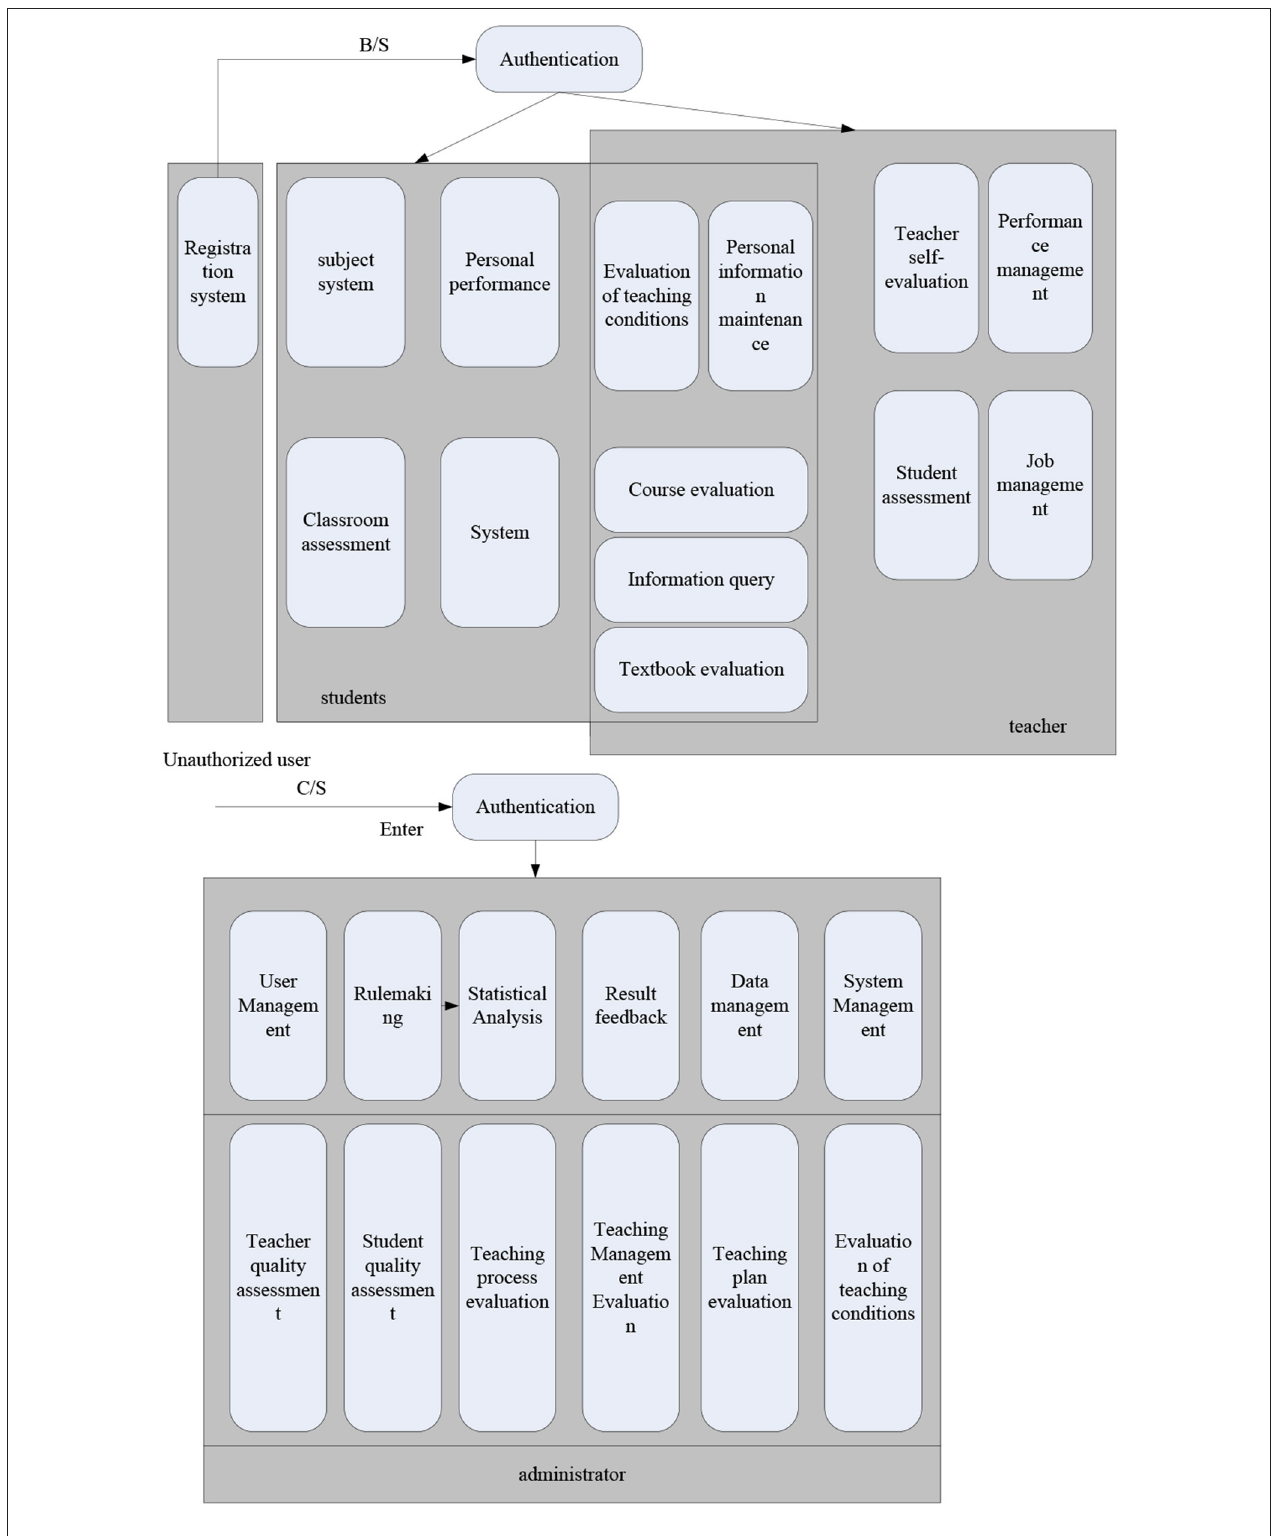
FIGURE 5 | System function module